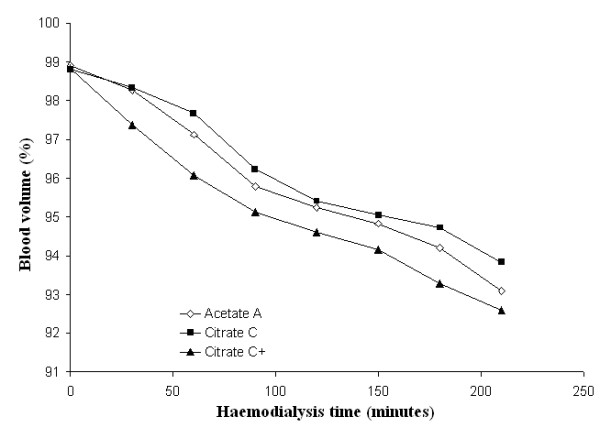
Blood volume. Blood volume as a function of the haemodialysis time using respectively acetate (A) (empty diamonds), calcium uncorrected citrate (C) (black squares) and calcium supplemented citrate dialysate (C+) (black triangles).